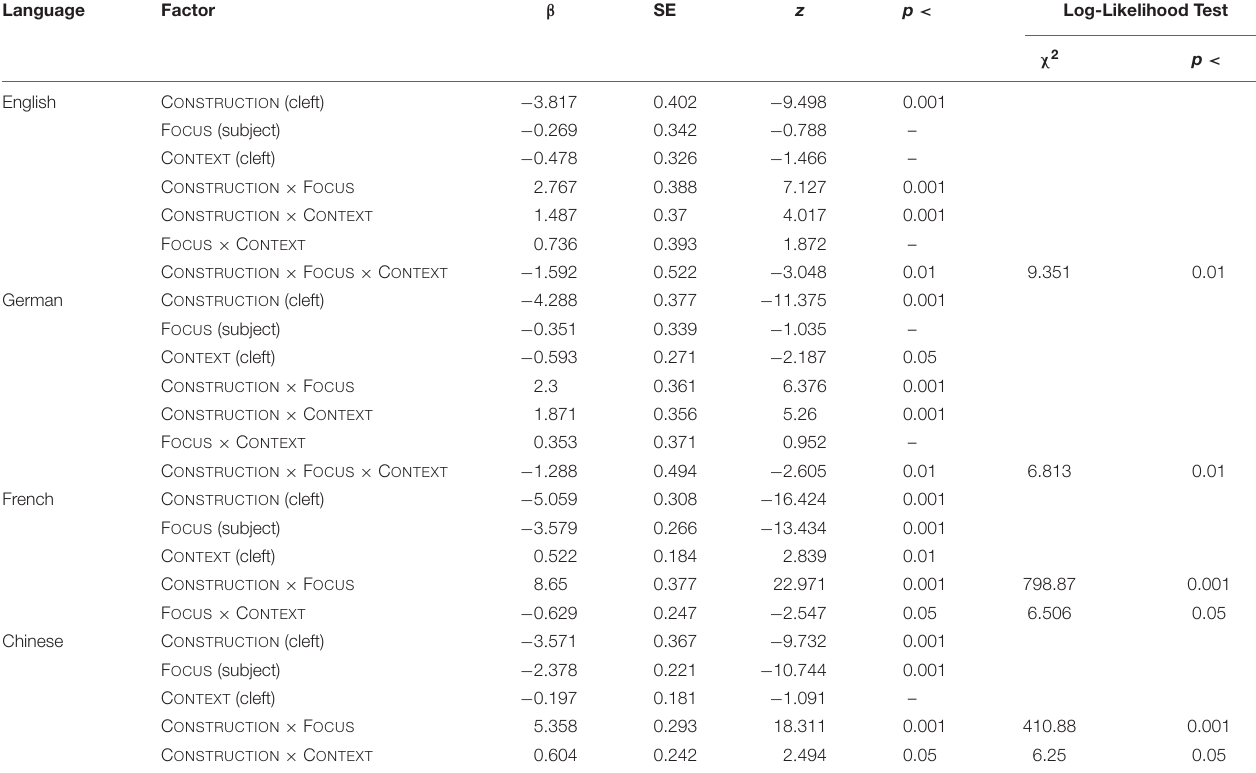
TABLE 3 | Cumulative link models on the ordinal scale of contextual felicity.